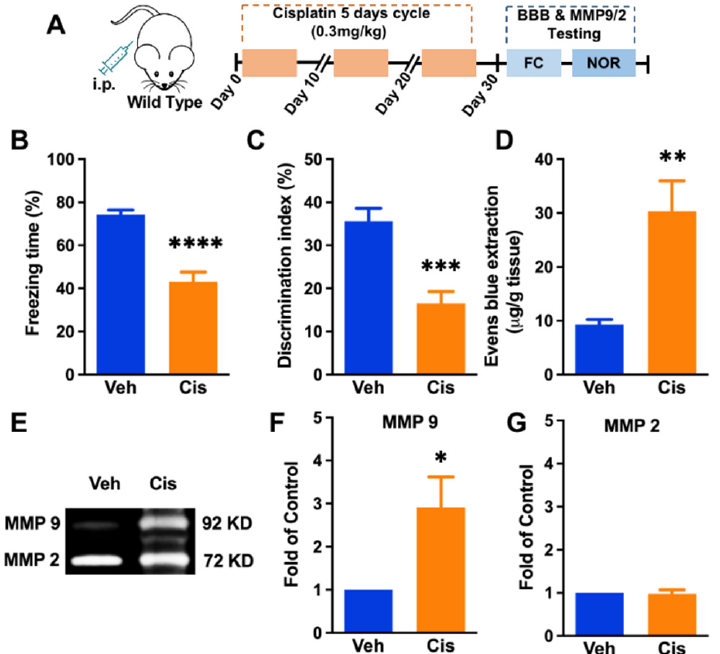
Figure 1. Repeated treatment of cisplatin-induced cognitive impairment, BBB interruption, and increased level of hippocampal MMP-9. ( A ) Behavior paradigm. ( B ) The deficiency in freezing behavior following cisplatin repeated infusion. n = 8. ( C ) The deficiency in the novel object recognition test following cisplatin repeated infusion. n = 8. ( D ) The Evans Blue extraction value in hippocampus tissue. n = 5. ( E ) Gelatin zymography shows activity changes of hippocampal MMP-9 and MMP-2 induced by cisplatin. ( F ) The fold of MMP-9 changes. ( G ) The fold of MMP-2 changes. n = 5, unpaired t -test ( p * < 0.05, p ** < 0.01, p *** < 0.001, p **** < 0.0001 cisplatin vs. vehicle).